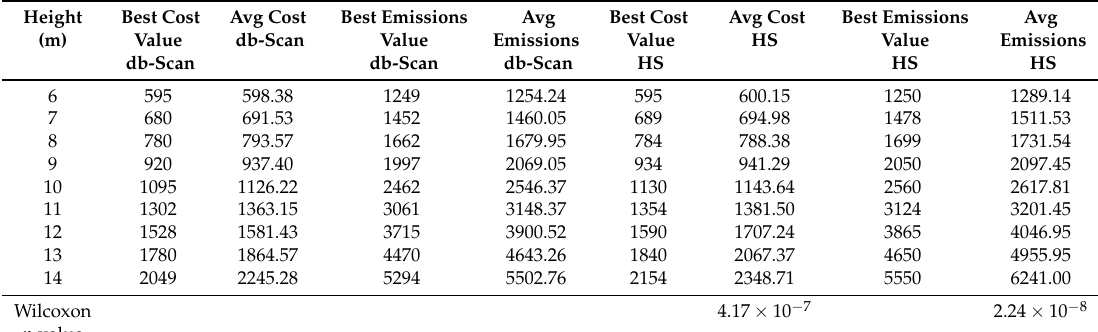
Table 7. Comparison between db-scan PSO and HS algorithms in cost and emission